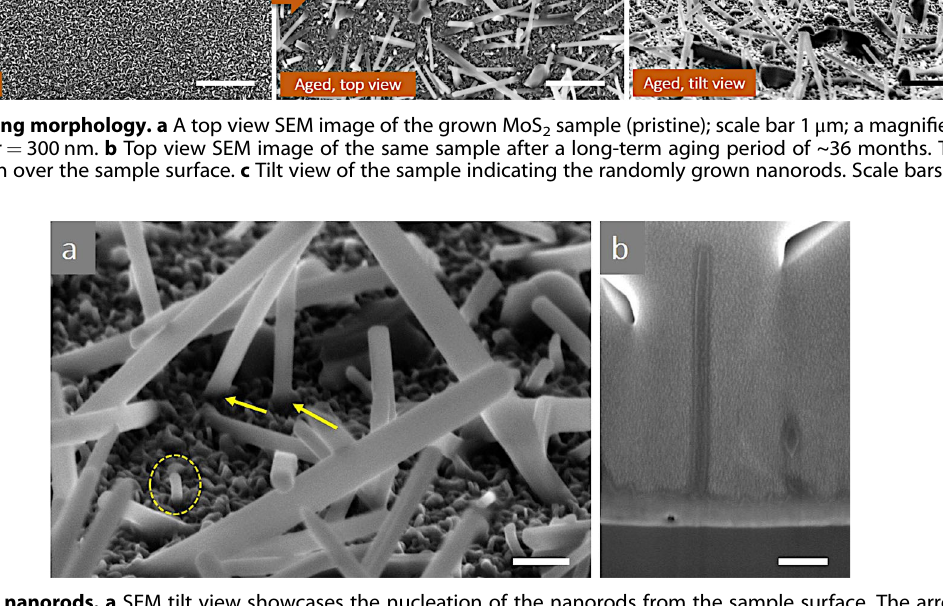
Fig. 2 Nucleation of nanorods. a SEM tilt view showcases the nucleation of the nanorods from the sample surface. The arrows indicate the nanorods seeds emanating from the MoS 2 fi lm. A growing nanorod is highlighted by the yellow dotted line which could be at its early stage of nucleation and growth. b A cross-sectional SEM image of a vertically grown nanorods. Scale bars in a and b 200